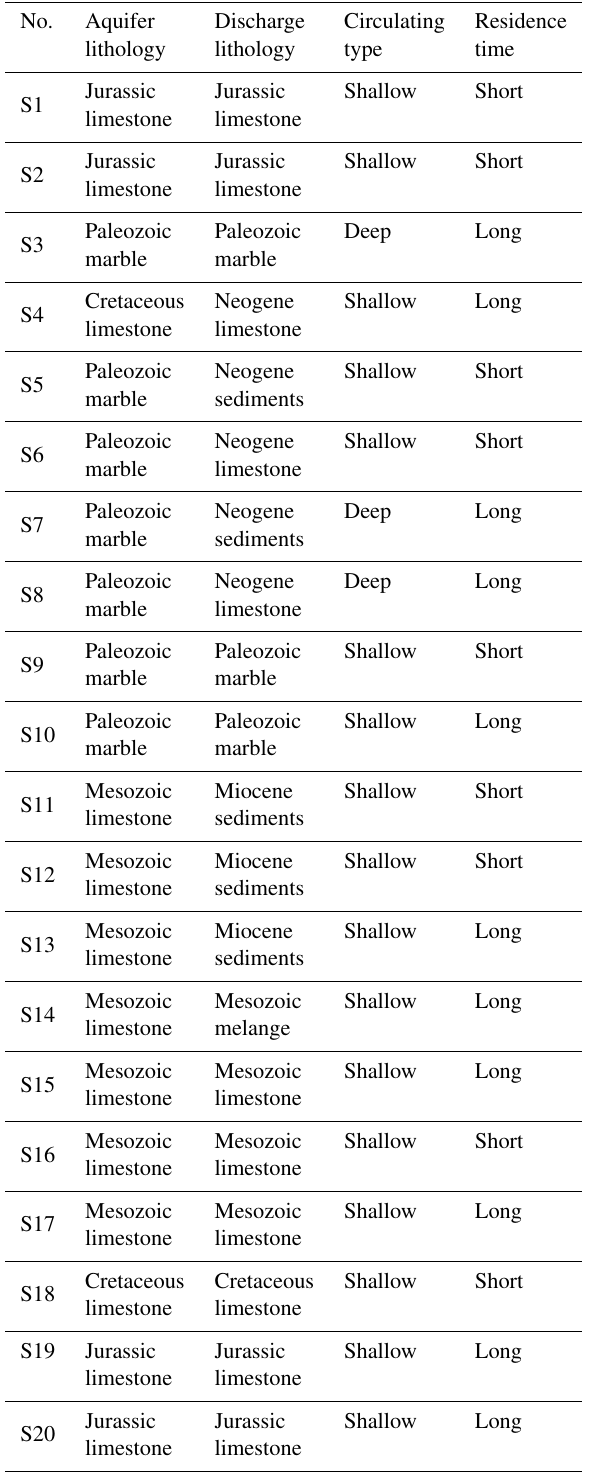
Table 2. Hydrogeological data of